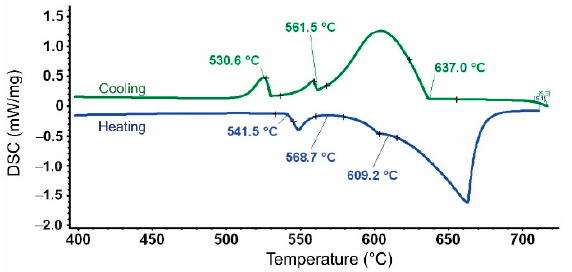
Figure 2. Results from DSC analysis of as-cast sample from EN AW 2011 aluminium alloy .